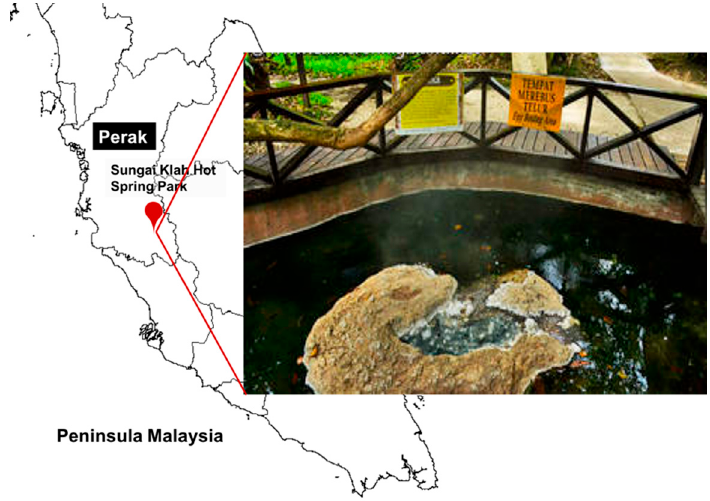
Figure 1. Sungai Klah Hot Spring Park located in Perak, Malaysia.